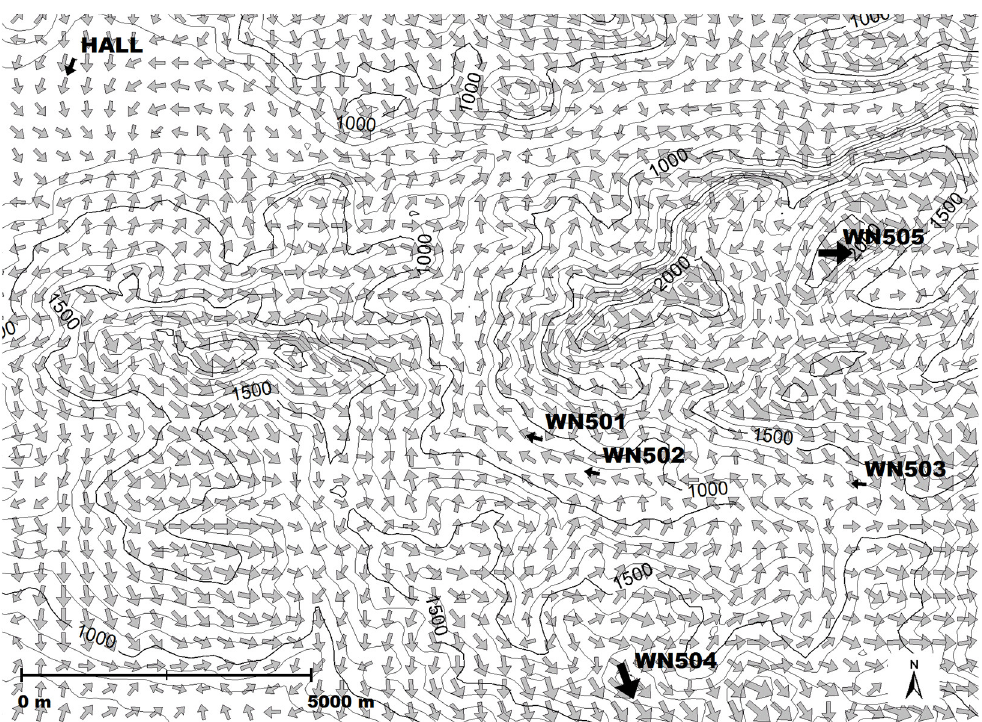
Figure 9. Observed and modelled wind speed and direction at selected sites in the Johnsbach ( left ) and Feldbach ( right ) domains. Dotted lines refer to GRAMM-SCI results, full lines to observations, black refers to wind direction, and grey to wind speed.